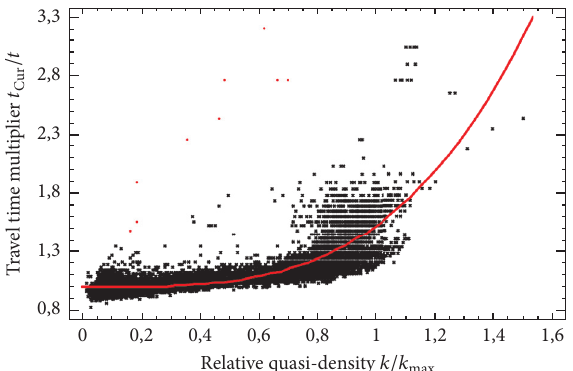
Figure 9: BPR function (red) fitted to 𝑡 Cur / 𝑡 against 𝑘/𝑘 max data, 𝑎 = 0.52 and 𝑏 = 3.47 .